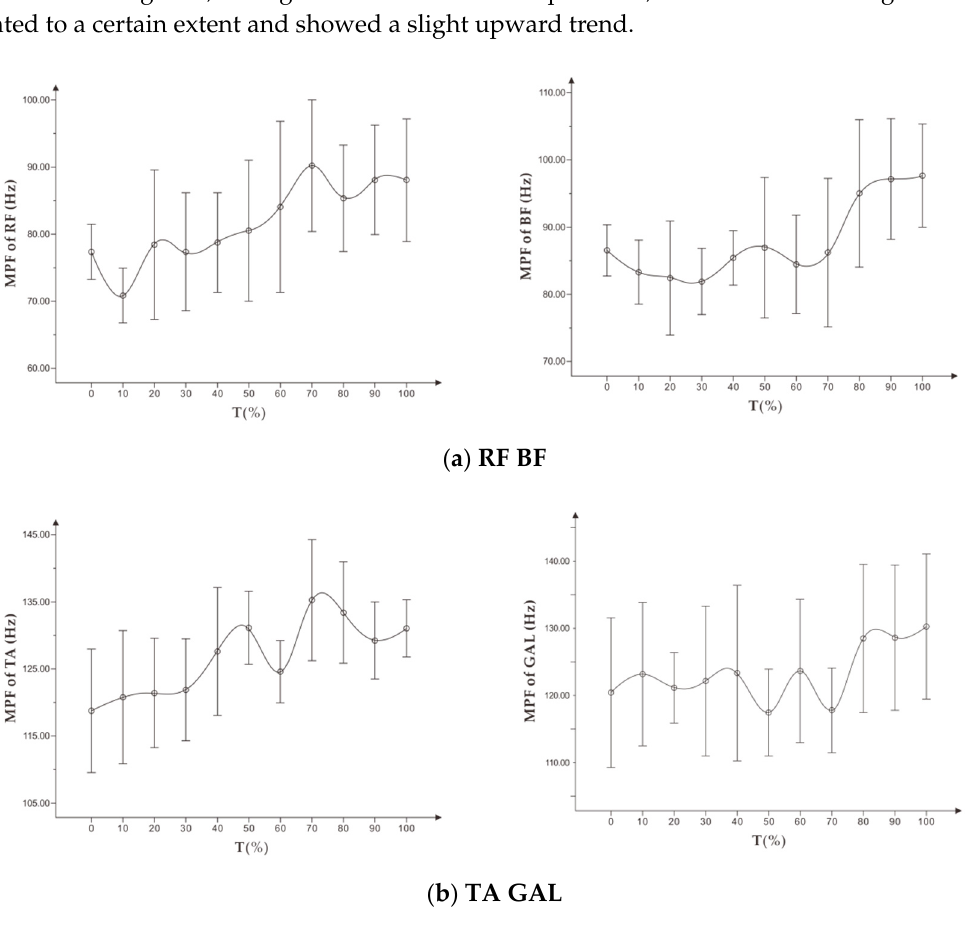
Figure 4. ( a ) shows the trend of MPF ( x(cid:3364) ± s) on RF, BF, and ( b ) shows the trend of MPF ( x(cid:3364) ± s) on TA, GAL in the incremental load experiment.